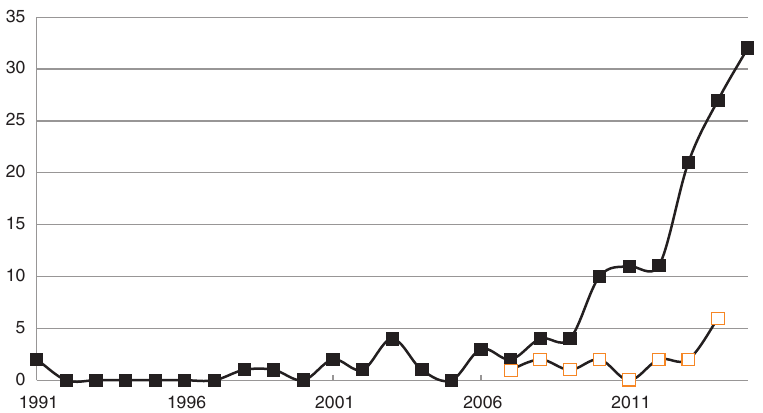
Figure 1: Nanomedicine publications emanating or including a South African institution up to December 2015. The source of the publica- tions is PubMed, and publications were retrieved based on key words outlined in the text. ( ) indicates drug delivery articles, and ( ) indicates articles in the nanoparticle diagnostics space. No eligible research articles in nanoparticle-based diagnostics, on PubMed, meeting the inclusion criteria were identified for 2015 and, therefore, are not